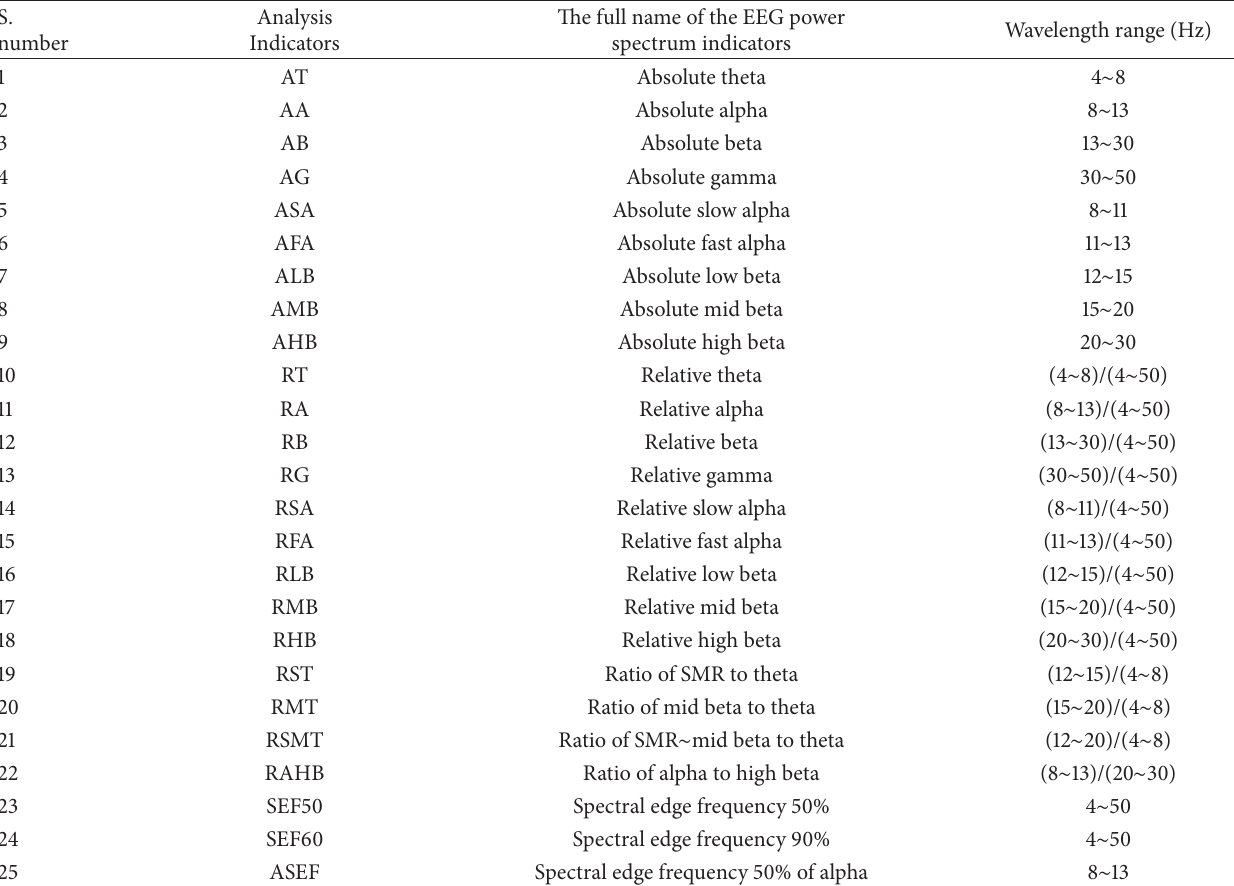
Table 1: EEG power spectrum indicators used in this